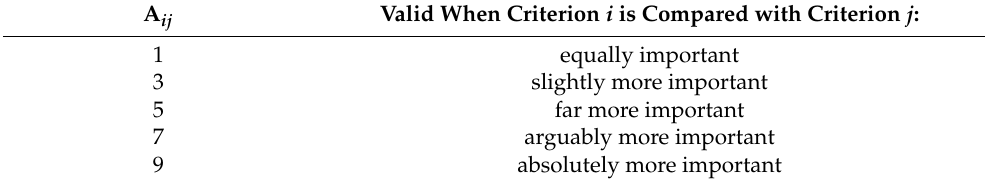
Table 2. Saaty rating